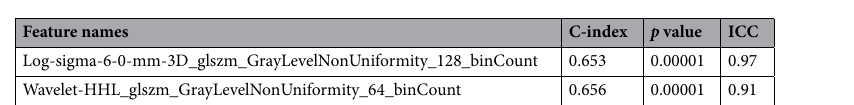
Table 2. The characteristics of selected features for model building in sensitivity analysis. The univariate C-index, p -value, and ICC were tabulated. Feature names indicate the feature, the bin count (if applicable), and the image used to compute